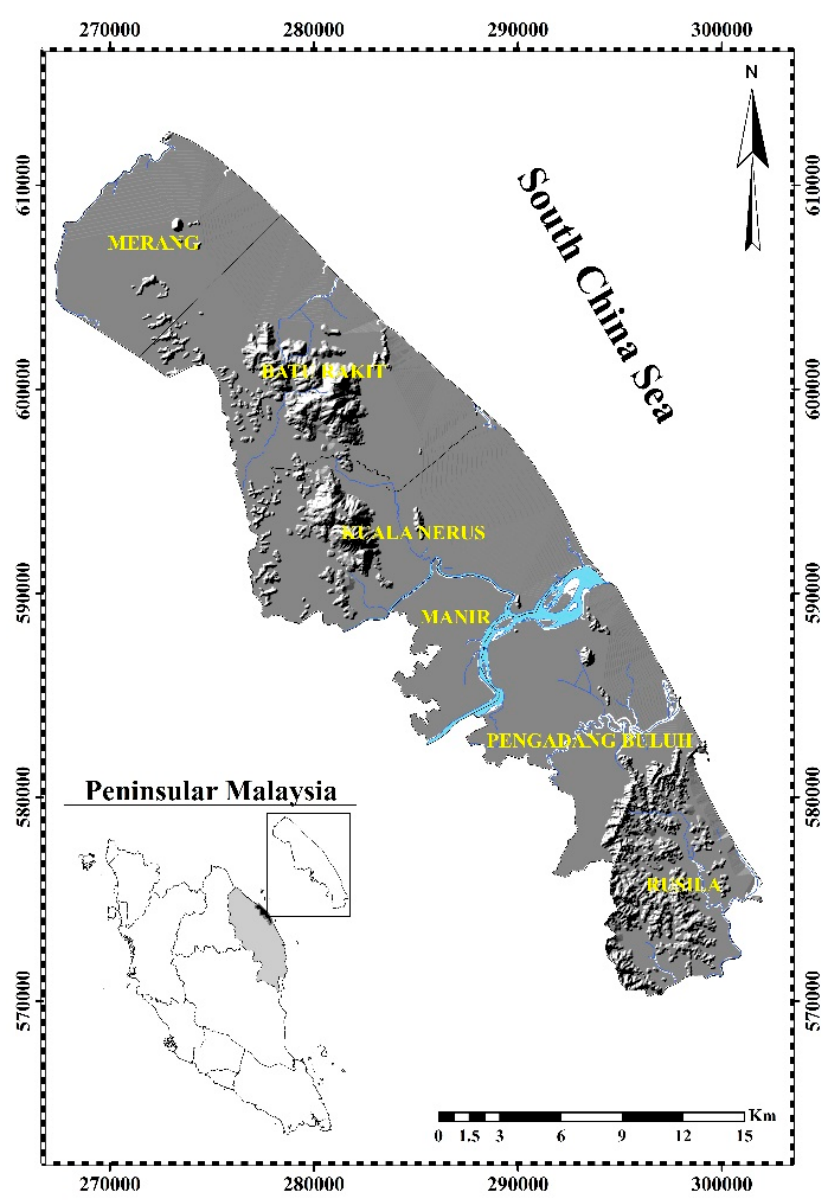
Figure 1. The geographical location of Kuala Terengganu in Peninsular Malaysia.